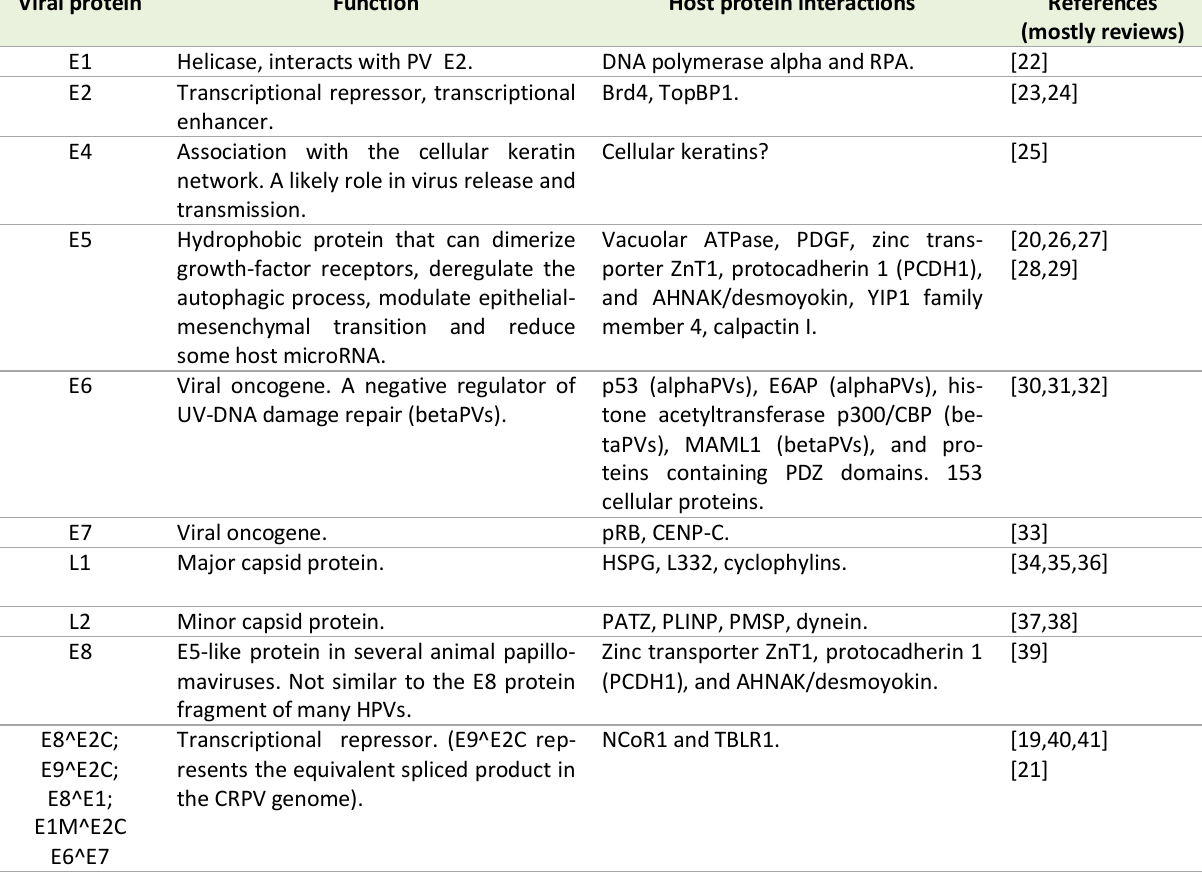
TABLE 1. Papillomavirus proteins and functions. Viral protein